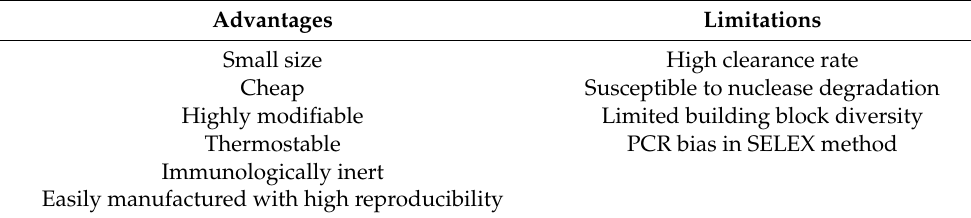
Table 1. Summary of aptamer advantages and